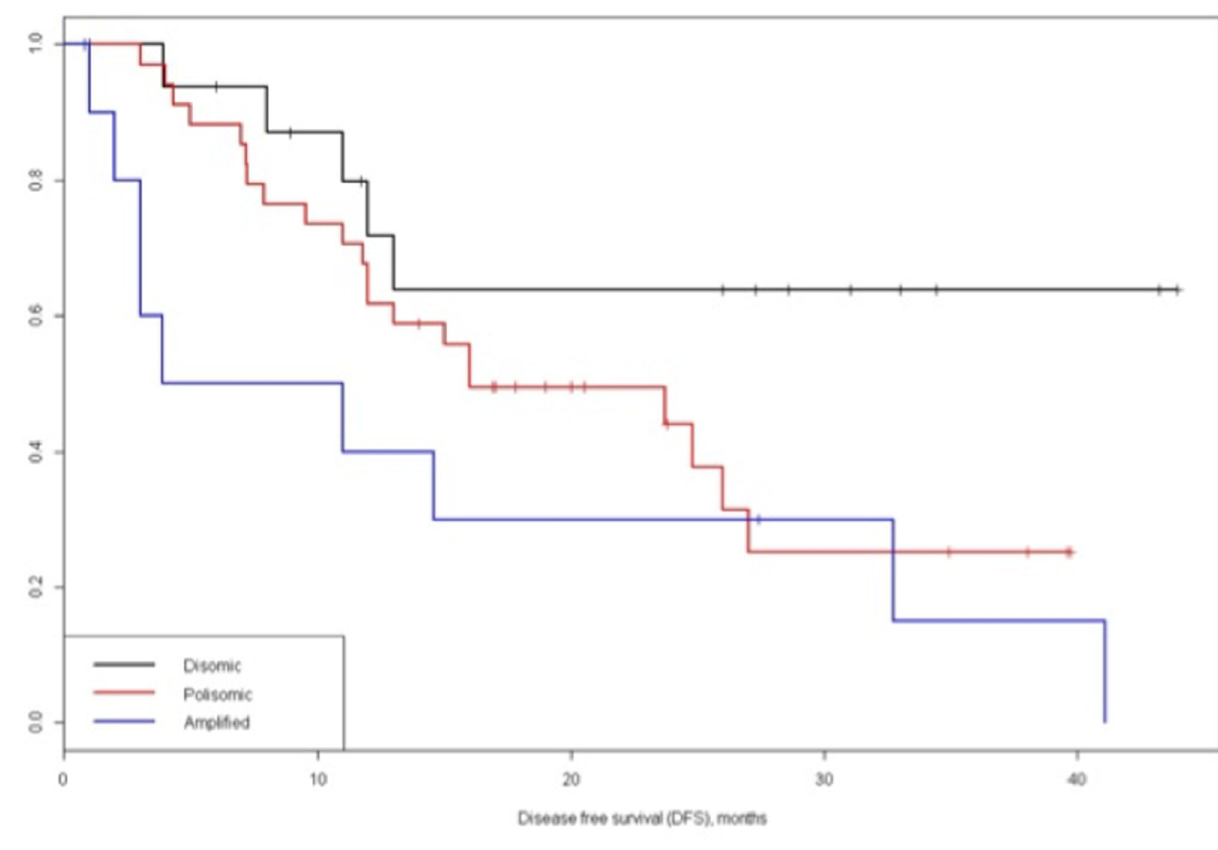
Figure 5. Disease free survival (DFS) of c-myc disomic, polysomic and amplified groups. doi: